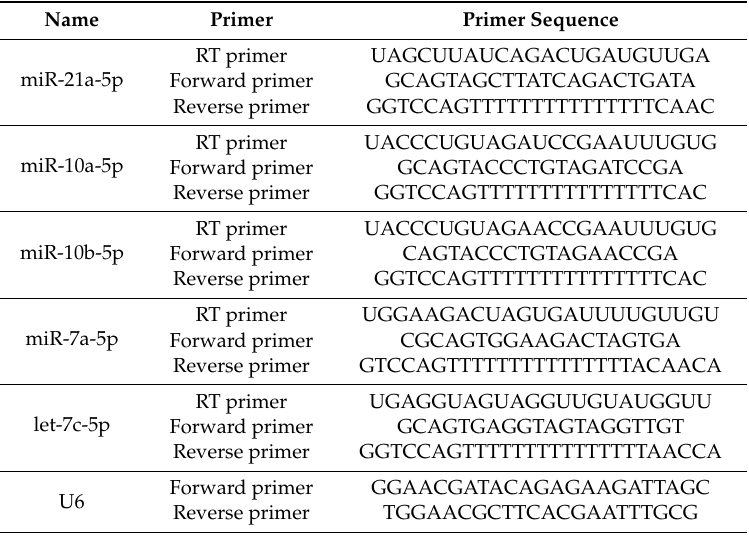
Table 1. The information of primers used in this